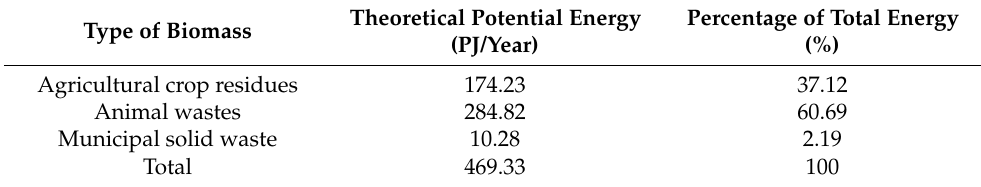
Table 6. Theoretical potential energy from biomass residues in